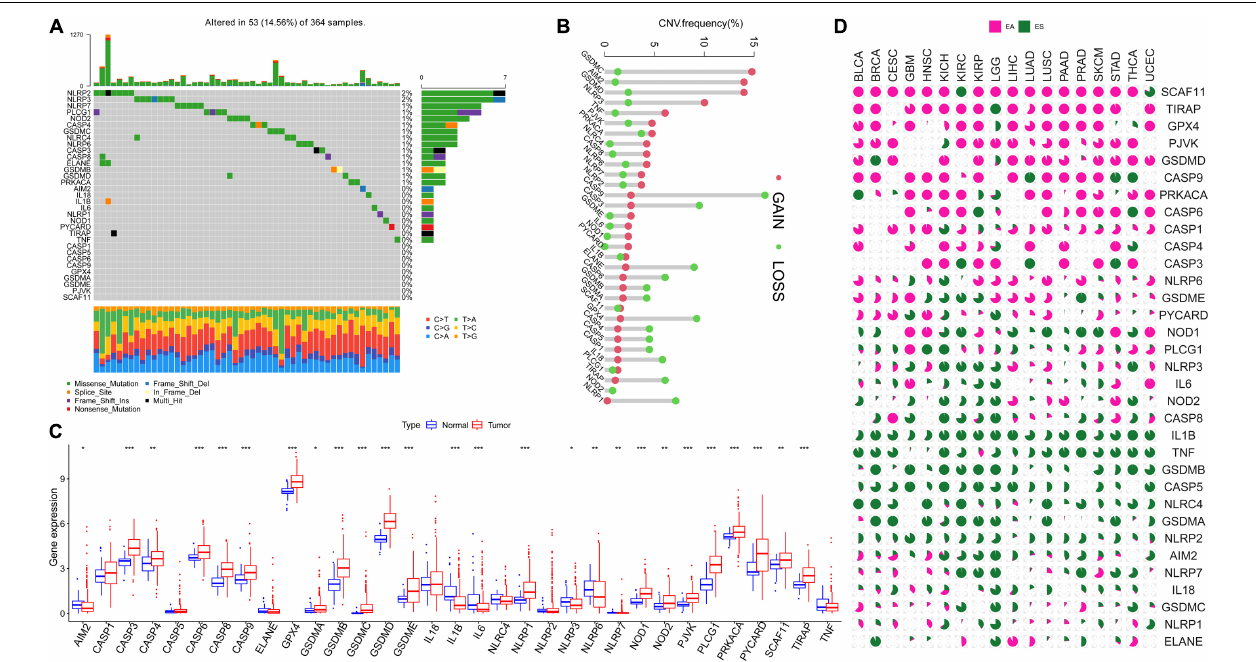
FIGURE 2 | Landscape of 33 pyroptosis-related genes (PRGs) in hepatocellular carcinoma. (A) The occurrence of copy number variation (CNV) and somatic mutations of 33 PRGs in The Cancer Genome Atlas—Hepatocellular Carcinoma (TCGA-HCC): among 364 samples, 53 experienced mutations with a frequency of 14.56%, and NLRP2/3 demonstrated the highest mutation frequency. (B) The analysis of CNV alteration frequency displayed that CNV changes were common in 33 PRGs; the result indicated that GSDMC , AIM2 , and GSDMD had a general frequency of CNV gain, and CASP9 had a widespread frequency of CNV loss. (C) The expression of 33 PRGs between normal and tumor cells in TCGA-HCC. (D) The impact of 33 PRGs on EA or ES in different cancer types; the result suggested that CASP family genes mainly affect EA, whereas the NLRP family genes mainly affect ES; pink represents EA and green represents ES. EA, epigenetically activated; ES, epigenetically silenced. The asterisks represent the statistical p -value (* p < 0.05; ** p < 0.01; *** p < 0.001).